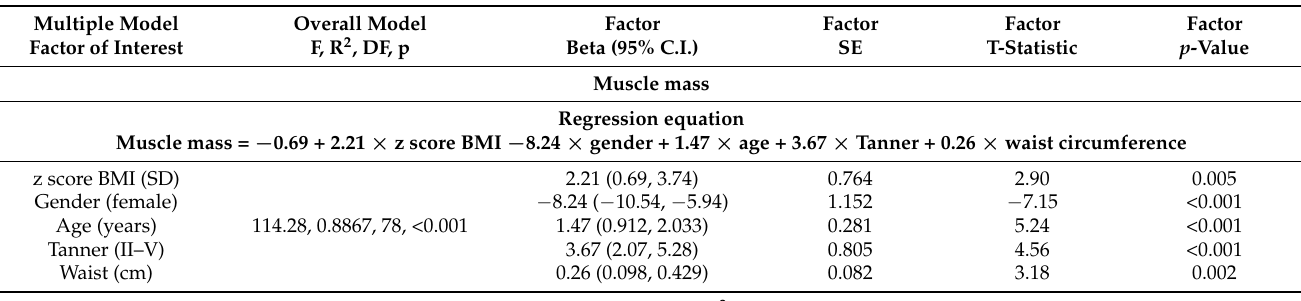
Table 6. Multiple regression models of muscle mass, after applying the forward stepwise method for variable insertion and evaluation with demographic and anthropometric data.